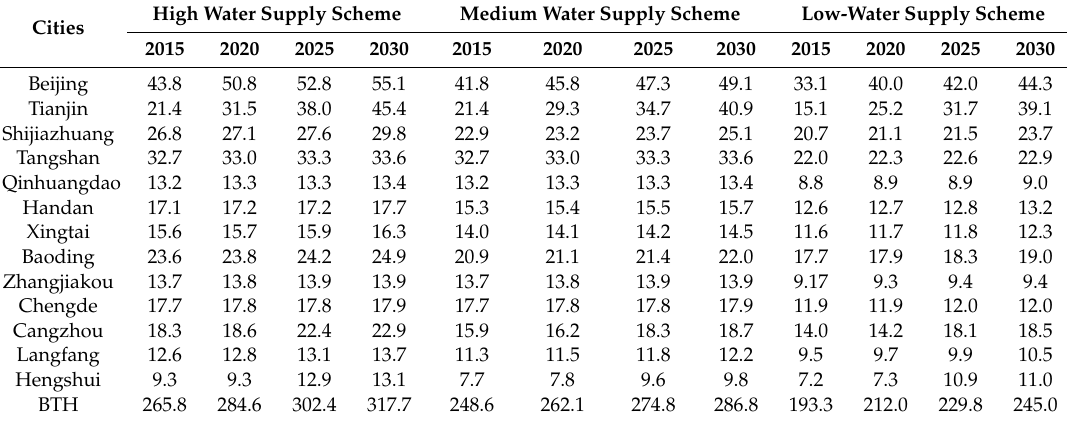
Table 1. Water supply of di ff erent schemes in BTH urban agglomeration (10 8 m 3 ). High Water Supply Scheme Medium Water Supply Scheme Low-Water Supply Cities